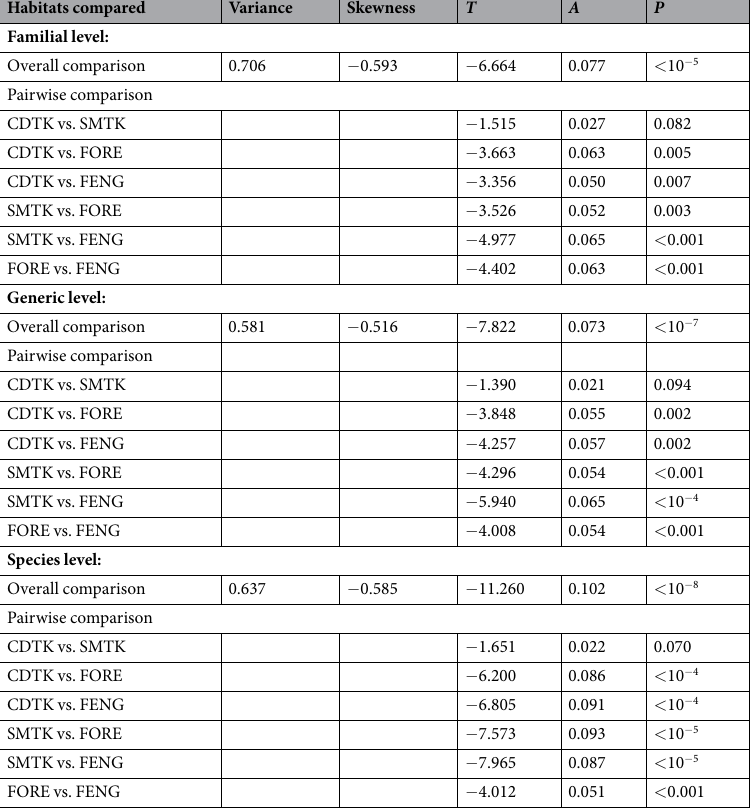
The geographical differences in the relationships between the vegetation and the morphogenesis of tiankengs and dolines are still to be explored, in order to determine the mechanisms driving tiankengs’ functionality as the refugia for the local biota. Our study of the tiankeng flora and forest communities in the karst areas in southwest- ern China will provide an important case study for the international karst and speleology research, biodiversity